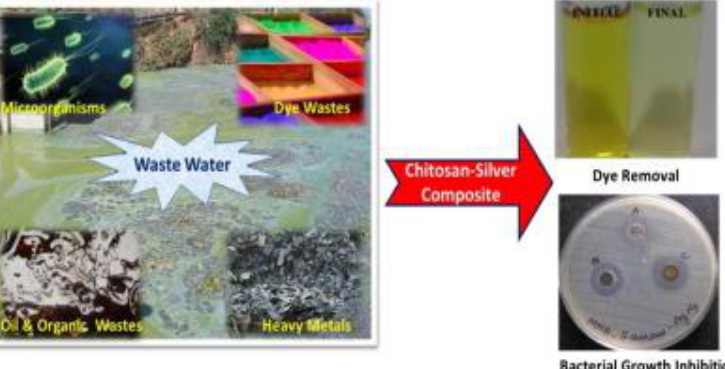
Figure 2. Eco-friendly approach of chitosan/silver nanocomposite used for dye removal for potable water. “Reprinted with permission from [66]. Copyright 2022, Elsevier”.